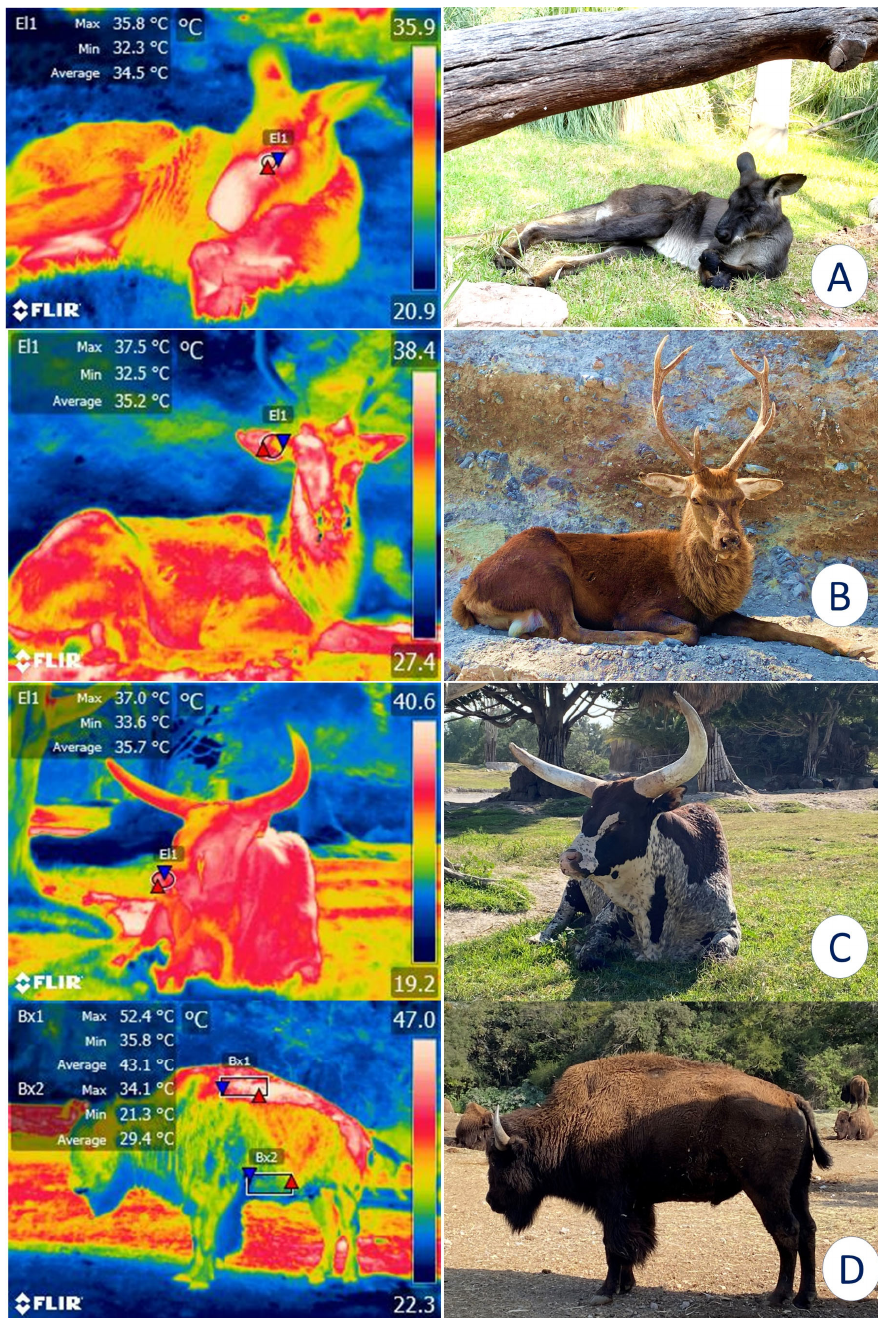
Figure 3. Importance of natural or artificial shade for the thermoregulatory behavior of various species. ( A ). Although this kangaroo ( Osphranter rufus) is resting under natural shade, the average temperature of the lacrimal caruncle (El1) is 34.5 ◦ C. ( B ). A sika deer ( Cervus nippon ) under shade shows an average temperature of 35.2 ◦ C in the auricular region (El1). ( C ). The average nasal temperature of 35.7 ◦ C of an ankole-watusi ( Bos taurus taurus ankole ) under the shade of a tree is depicted. ( D ). In an American bison ( Bison bison ), a comparison between the dorsal (Bx1) and ventral (Bx2) regions can be observed. An average temperature difference of 13.7 ◦ C was registered between them. Therefore, shaded areas are a key element for ensuring the thermal comfort of wild animals under human care (Radiometric images and photographs by the authors). Maximum temperature (red triangle), and minimum (blue triangle). Thermal images obtained using a FLIR thermal